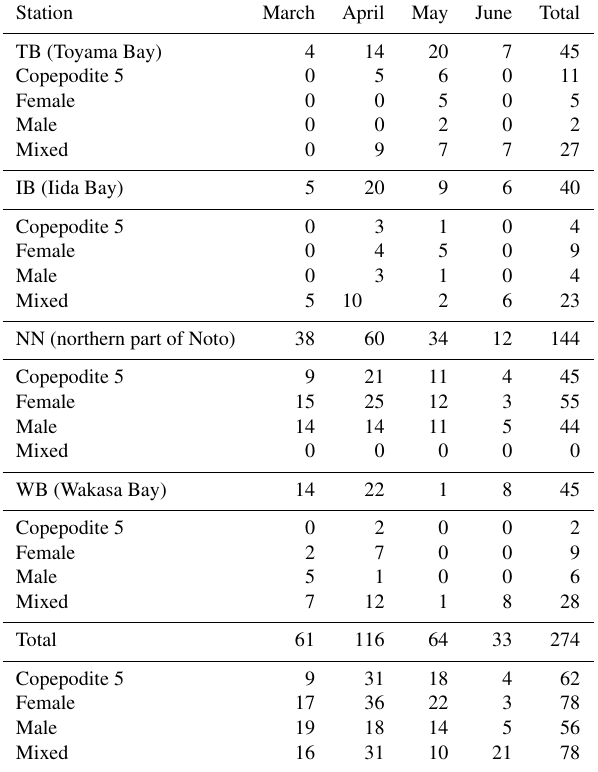
Table 1. Numbers of subsamples of Calanus sinicus for stable iso- tope